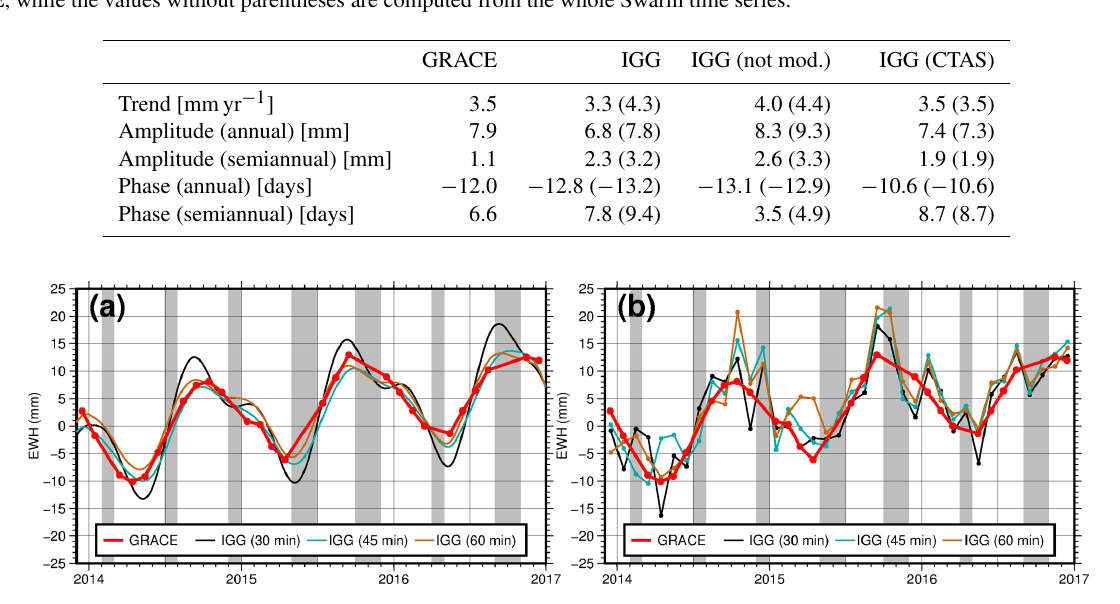
Figure 7. Effect of varying the arc length. (a) CTAS solution. (b) Monthly solutions.